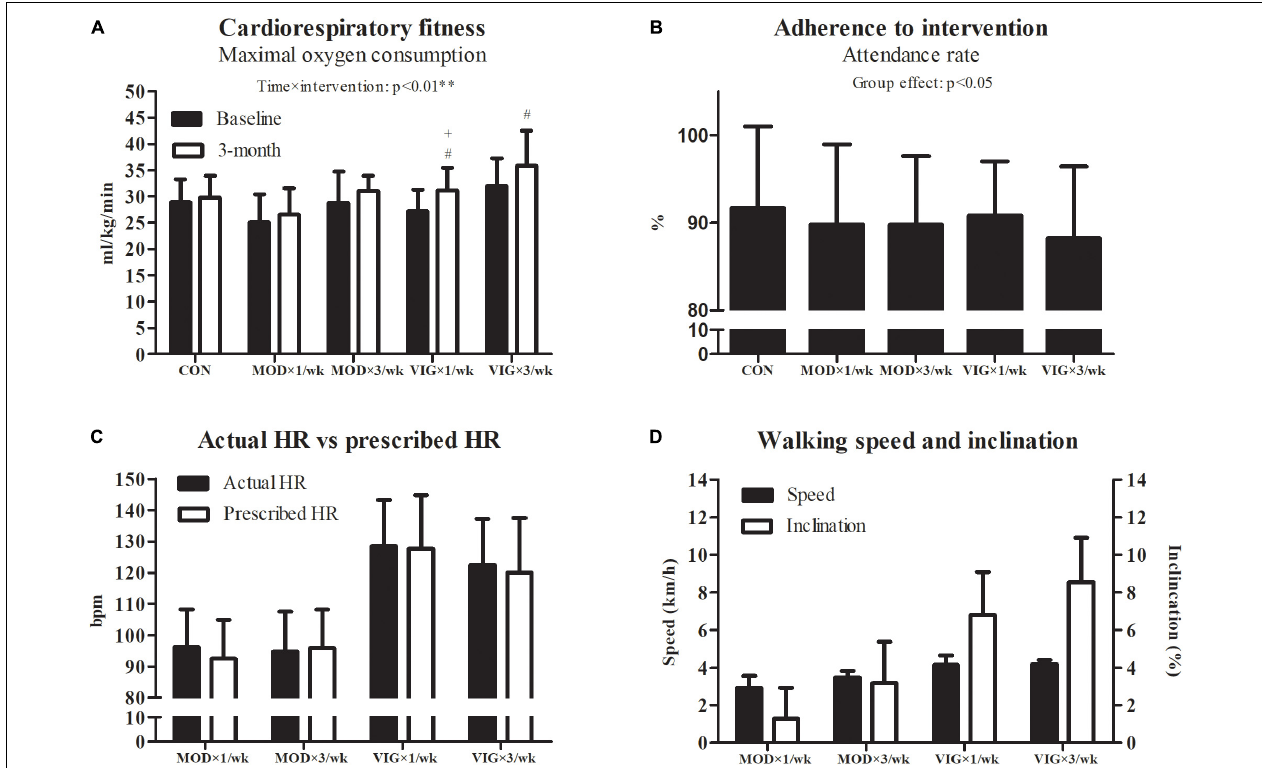
FIGURE 4 | Cardiorespiratory fitness (A) , adherence (B) , actual walking heart rate vs. prescribed heart rate (C) , and walking speed and inclination (D) . CON (attention CON group) = one session of 75 min stretching exercise weekly, VIG × 3/week = three sessions of 25 min vigorous-intensity (6.5 METs) walking exercise weekly, MOD × 3/week = three sessions of 50 min moderate-intensity (3.25 METs) walking exercise weekly, VIG × 1/week = one session of 75 min vigorous-intensity (6.5 METs) walking exercise weekly, MOD × 1/week = one session of 150 min vigorous-intensity (3.25 METs) walking exercise weekly. # Significantly different from CON at the same time point. + Significantly different from MOD × 1/week at the same time point.